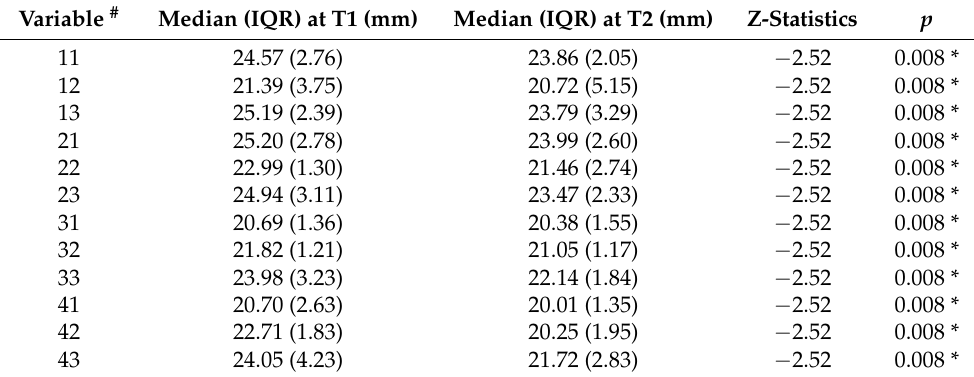
Table 4. Tooth length (root length and crown length) changes in CBNL